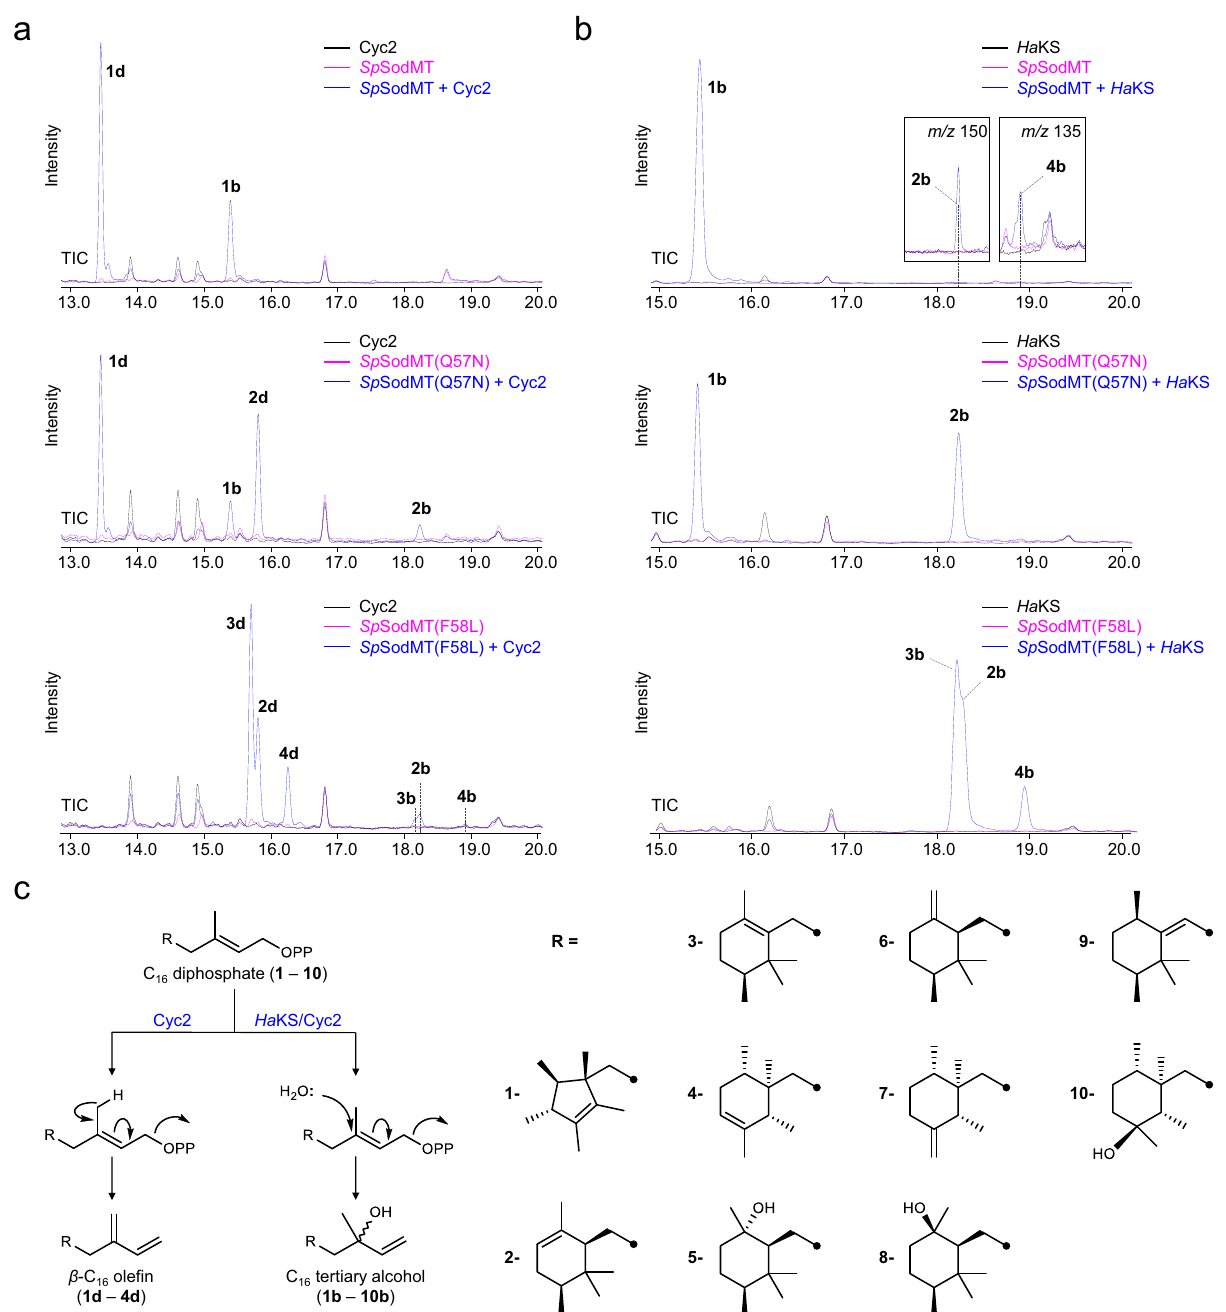
Fig. 5 | Production of terpene scaffolds using the C 16 building blocks. Chro- matograms showing production of C 16 terpenes in yeast by expression of Cyc2 or Ha KS together with Sp SodMT wild-type or variants (blue) versus cells expressing the corresponding methyltransferase but lacking the terpene synthase (pink) or transformed with empty vector (black). a In yeast cells expressing Sp SodMT(Q57N), Cyc2 produced the C 16 ole fi n 1d and the tertiary alcohol 1b from PSPP, and 2d and 2b from PPP. Yeast cells expressing Cyc2 with Sp SodMT(F58L) (blue) showed production of 2d and two C 16 ole fi ns ( 3d and 4d ). b In cells expressing wild-type Sp SodMT, Ha KS synthesized pre- sodorifelool ( 1b ) from PSPP (blue). Minor amounts of 2b and 4b were also observed (shown in the inset by selecting for m/z 150 or 135, respectively). Cells expressing Sp SodMT alone or Ha KS alone are shown as control (pink or black, respectively). In cells expressing Sp SodMT(Q57N), Ha KS produced 1b